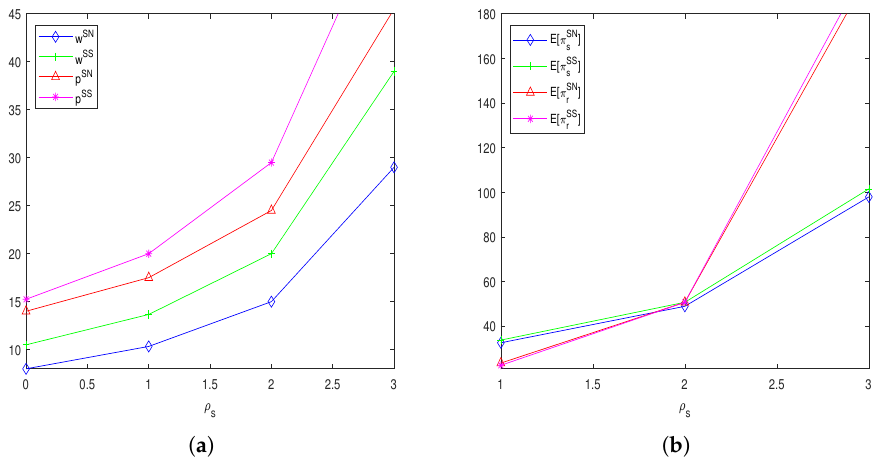
Figure 2. Impact of the freshness-keeping efficiency ρ s on the prices and profits in the SN and SS cases. ( a ) Effect of ρ s on the wholesale and retail prices; ( b ) effect of ρ s on the equilibrium profits.